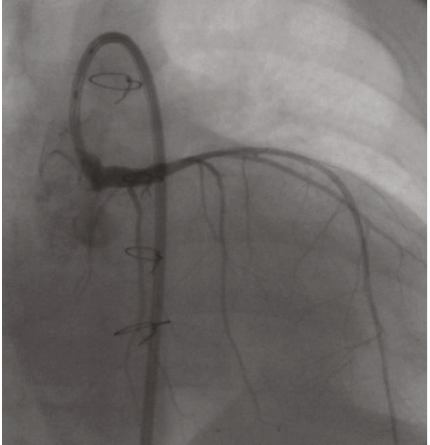
Figure 2: Reestablishment of LMCA perfusion after PCI.